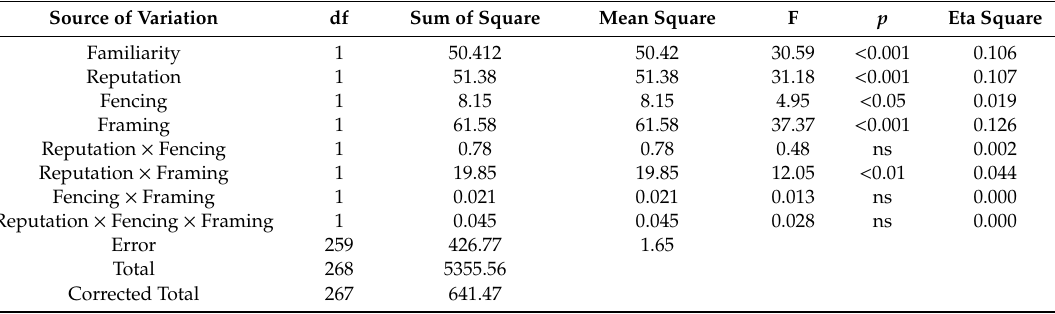
Table 3. Analysis of covariance (ANCOVA) results on perceived